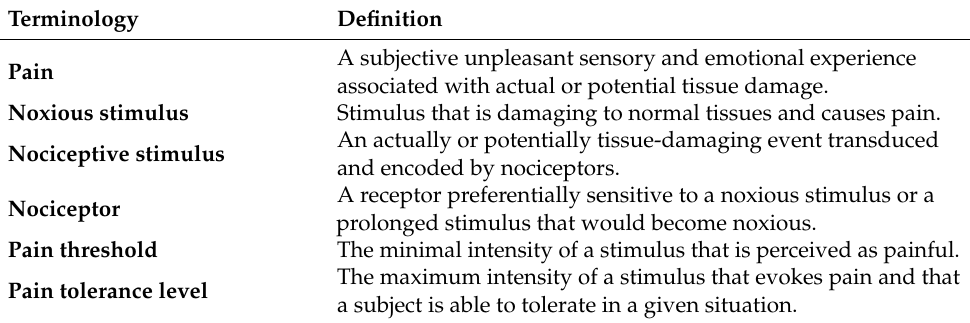
Table 1. IASP basic pain